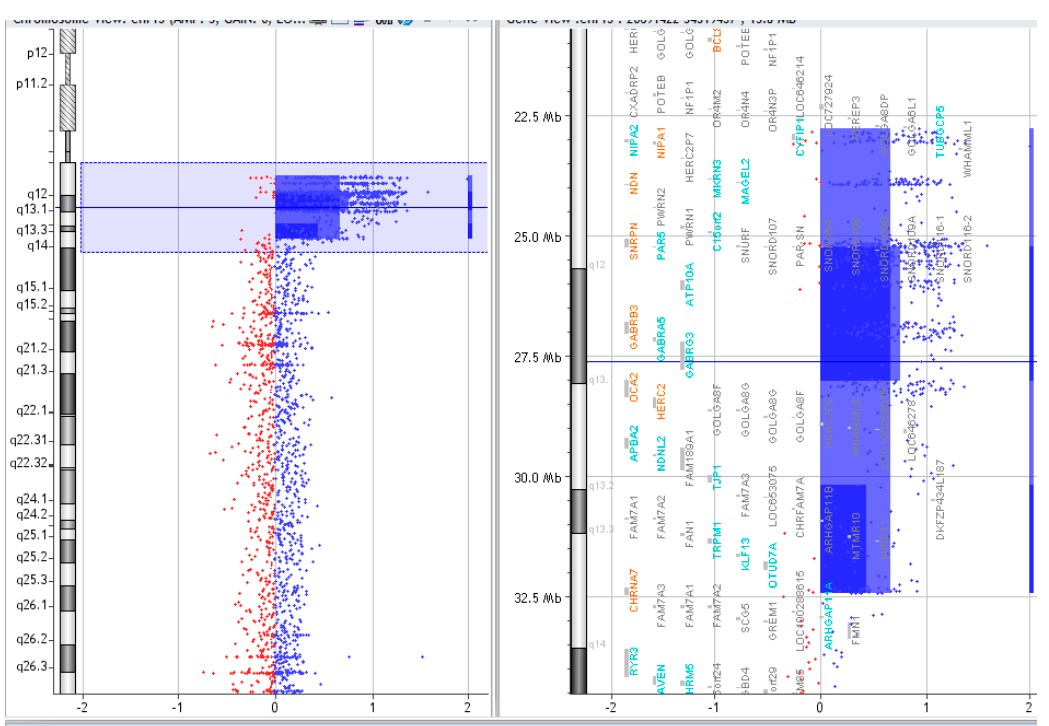
Figure 4. Array CGH results of P.3.